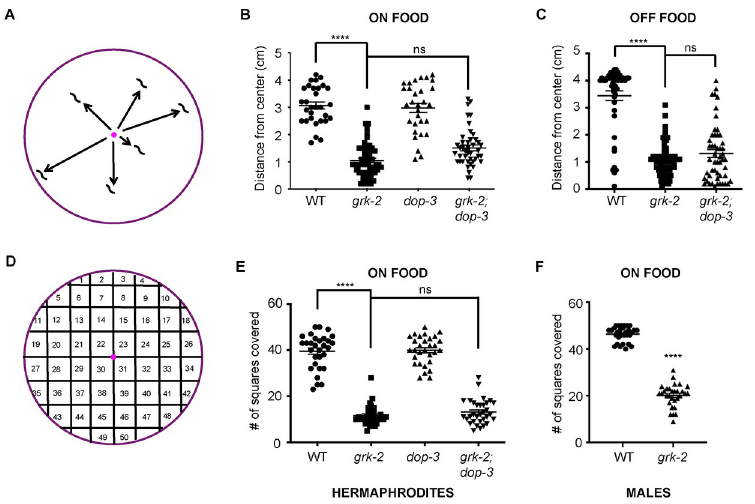
Fig 1. grk-2 mutant animals have dispersal and exploration defects. (A) Schematic representation of the assay used to measure dispersal (see Methods). (B) grk-2(gk268) mutant animals have a dispersal defect in the presence of food and dop-3(vs106) does not rescue this phenotype. Shown is the distance (cm) animals traveled from the center of the plate in the presence of food in 1 h. ( ���� , P < 0.0001. ns, P > 0.05. One way ANOVA followed by a Bonferroni test. Error bars = SEM; n = 30–53). (C) grk-2(gk268) mutant animals have a dispersal defect in the absence of food and dop- 3(vs106) does not rescue this phenotype. Shown is the distance (cm) animals traveled from the center of the plate without food in 20 min. ( ���� , P < 0.0001. ns, P > 0.05. One way ANOVA followed by a Bonferroni test. Error bars = SEM; n = 47–60). (D) Schematic representation of the assay used to measure exploration (see Methods). (E) grk- 2(gk268) mutant hermaphrodites have an exploration defect and dop-3(vs106) does not rescue this defect. Shown is the number of squares (out of 50) single animals covered in approximately 20 h. ( ���� , P < 0.0001. ns, P > 0.05. One way ANOVA followed by a Bonferroni test. Error bars = SEM; n = 30–32). (F) grk-2(gk268) mutant males have an exploration defect. ( ���� , P < 0.0001. Student’s t-test. Error bars = SEM; n = 30).